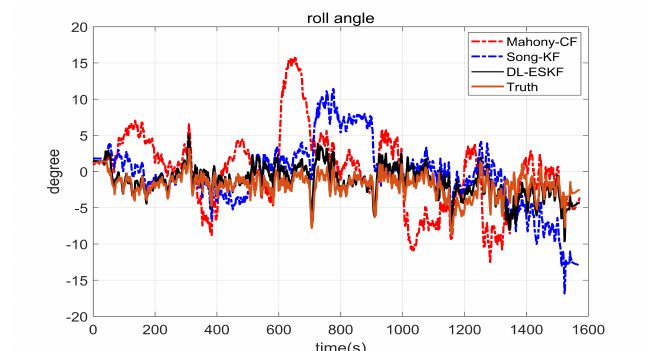
Figure 15. Roll angle under dynamic conditions.